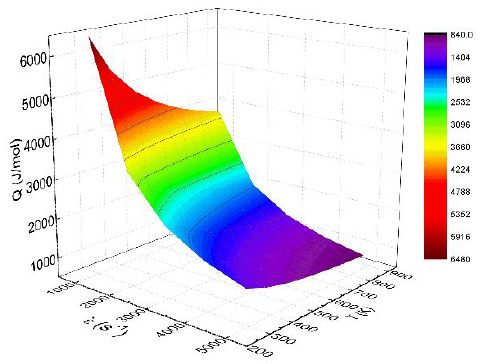
. ε ) on activation energy ( Q